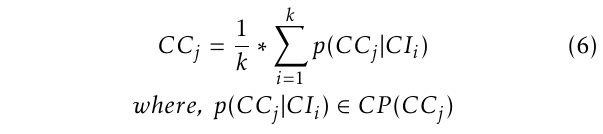
Figure 2. CC from Four’s Combination of Context Information